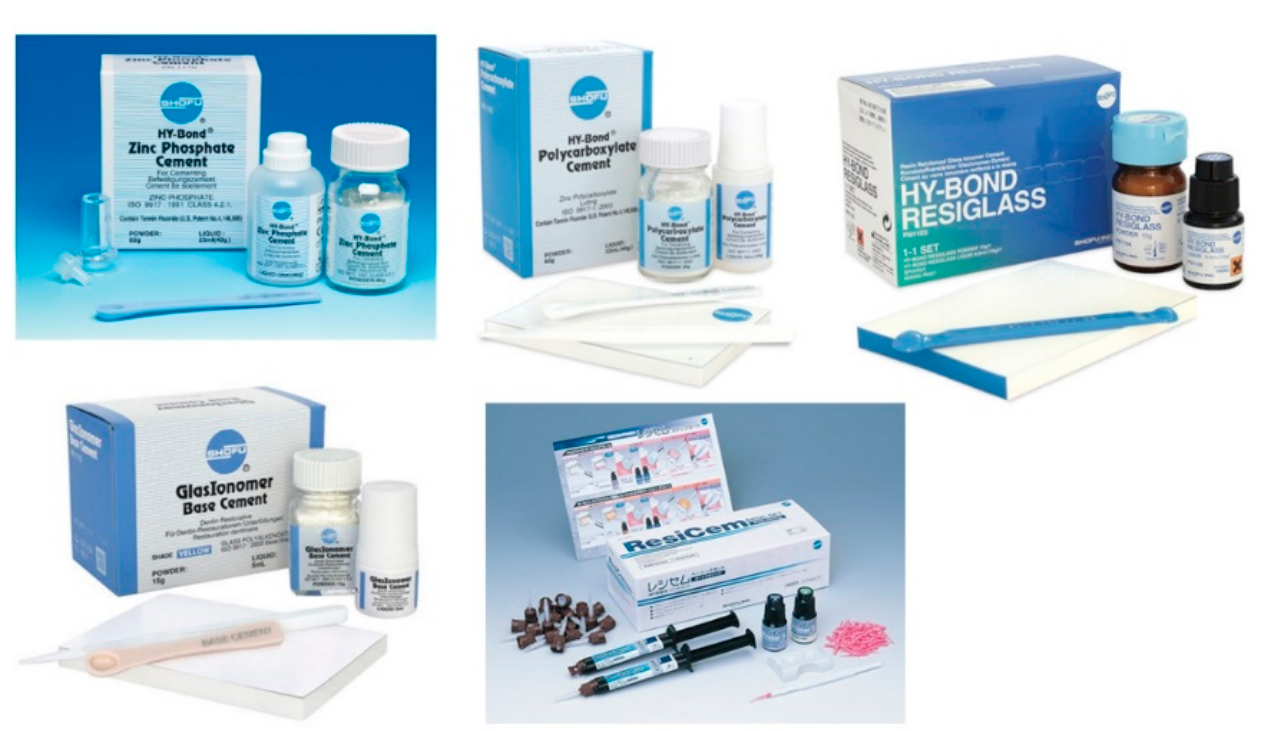
Figure 2. Long-term term cements (zinc phosphate cement, zinc polycarboxylate cement, glass- ionomer cement, resin-modified glass-ionomer cements, and resin cement) from Shofu